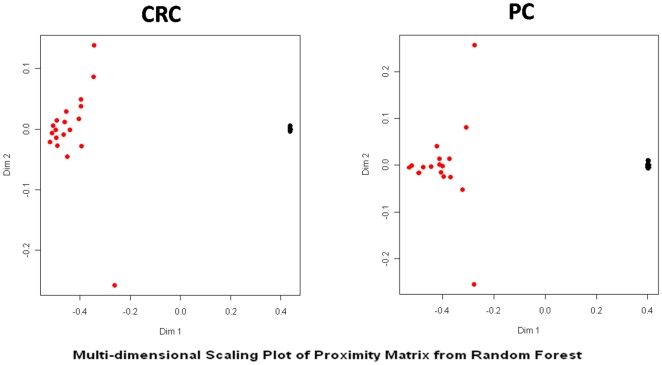
Multidimensional scaling plot.Proximity matrices from random forest analysis, where x- and y- axes are the multidimensional scaling coordinates. Subjects with similar miRNA expressions are represented by points close one to the other, whereas subjects with dissimilar miRNA expressions are represented by separated points. Red = tumor tissue, Black = adjacent normal tissue.